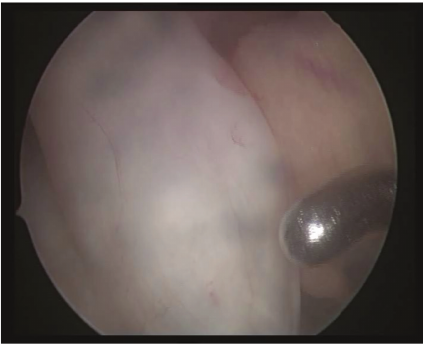
Figure 3: Arthroscopic view showing a swelling in the substance of the anteromedial bundle.